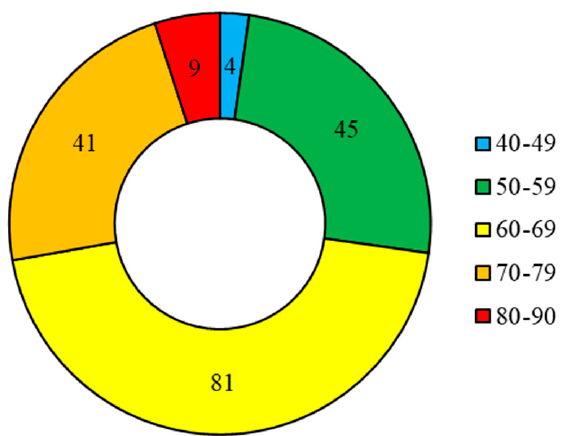
Figure 7. Frequency distribution of daily age of S. oualaniensis. The numbers in the doughnut diagram indicate the number of samples. Fitting the optimal growth model based on the statolith ring pattern, the logistic growth equation was the most suitable (AIC = 1199.549). The difference between logis- tic and AIC values of the Gompertz, von Bertalanffy and power growth equations was about 0.1, while the difference between logistic and logarithmic growth equations was 112.927 (Table 2), thus the logarithmic equation was excluded for describing the growth of S. oualaniensis